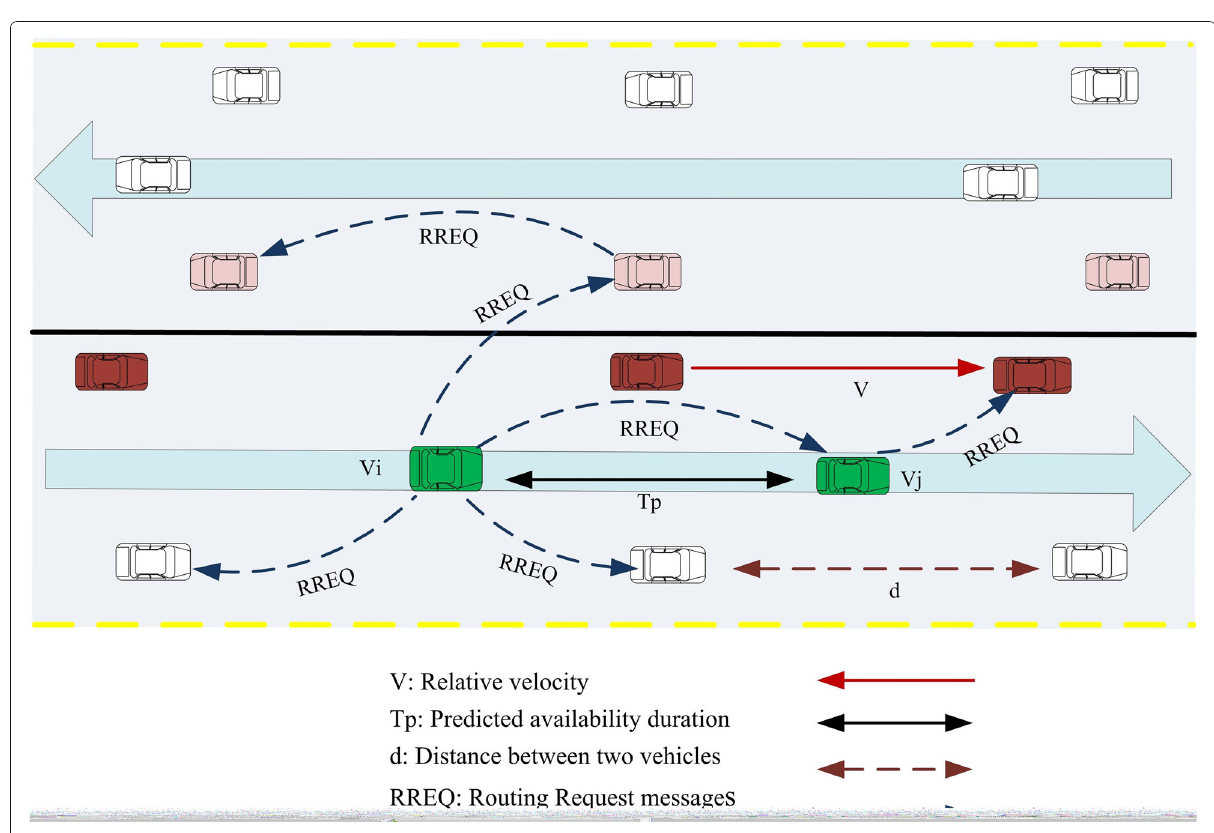
Fig. 2 Vehicular system model